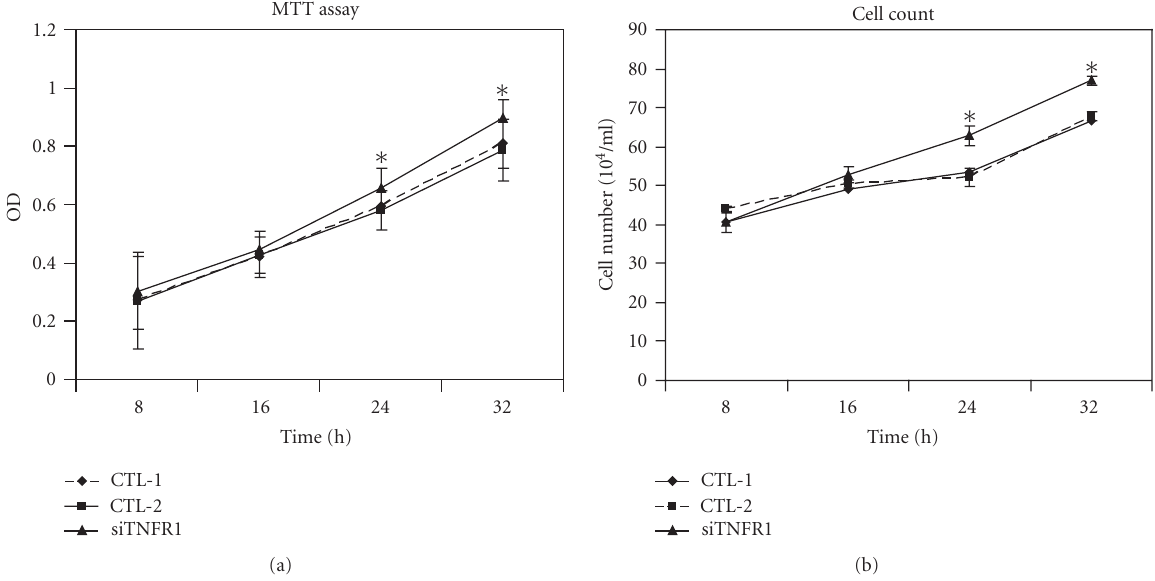
Figure 3: Silencing of the TNFR1 gene resulted in increased EC109 cell growth as determined by the MTT analysis (a) and cell count (b). CTL-1: blank control group; CTL-2: negative control group; Si-TNFR1: experimental group. The results show that the levels of proliferation between CTL-1 and CTL-2 were similar ( P > . 05); the levels of proliferation between CTL-1 and Si-TNFR1 were significantly di ff erent for the 24-hour and 32-hour time points ( P < . 05). Data represent the mean ± SD values of three experiments.